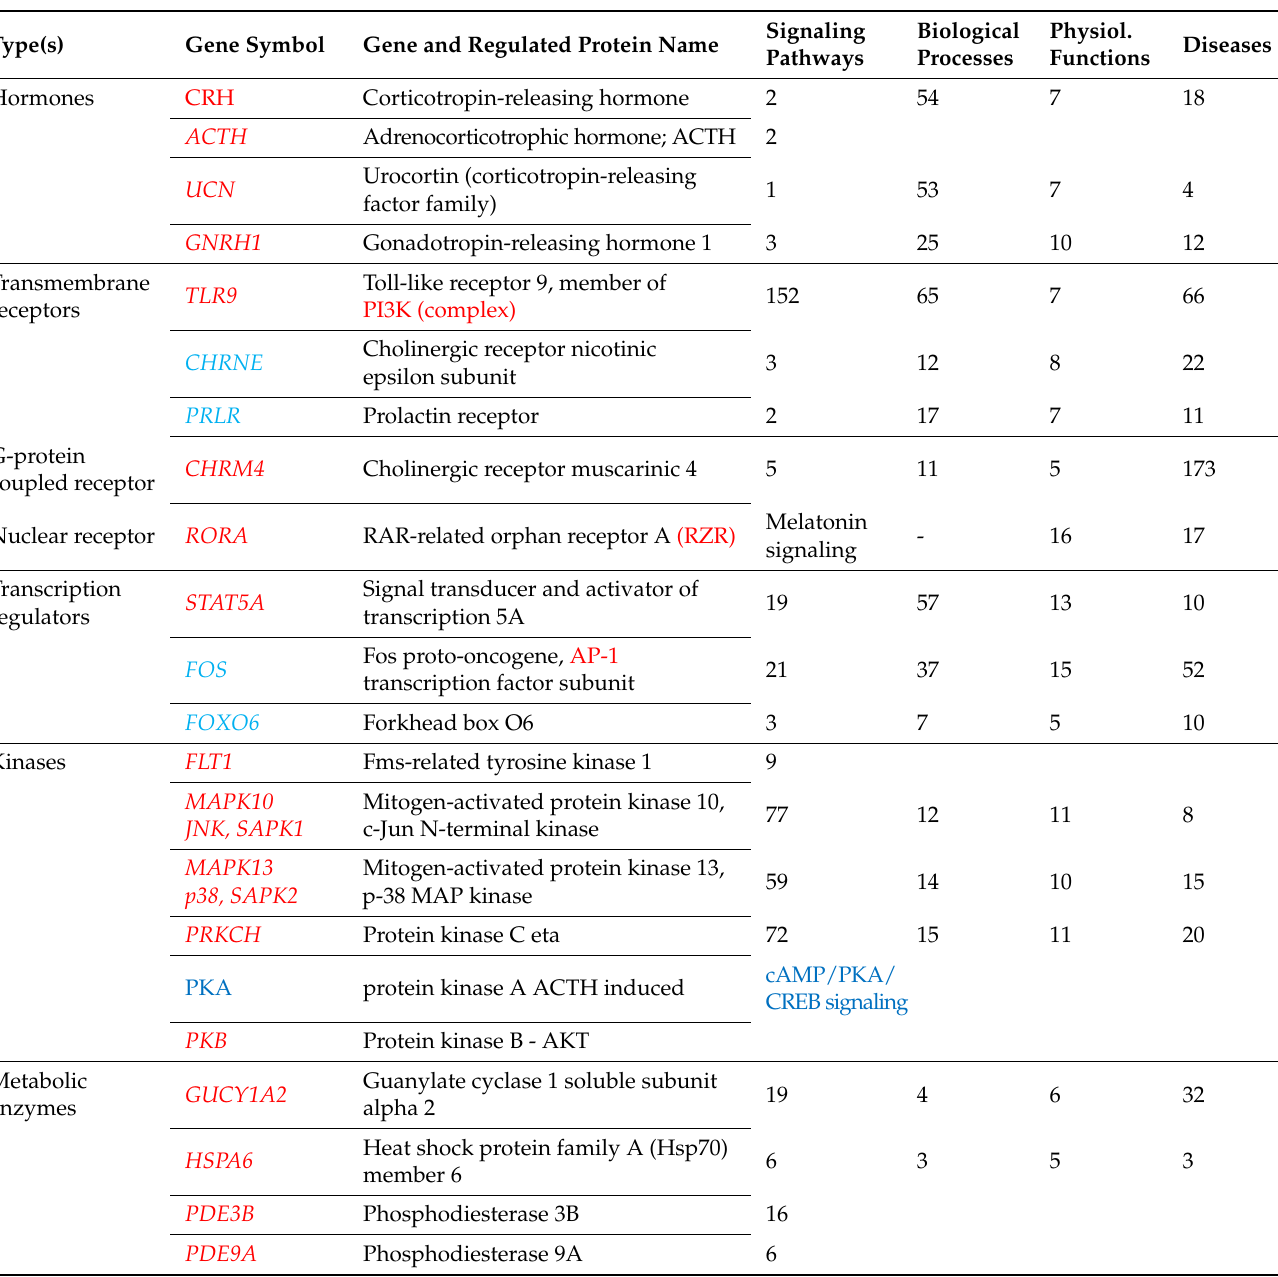
Table 2. Most essential genes regulated by adaptogens and associated signaling pathways, biological processes, physiological functions, and diseases; adapted from Reference